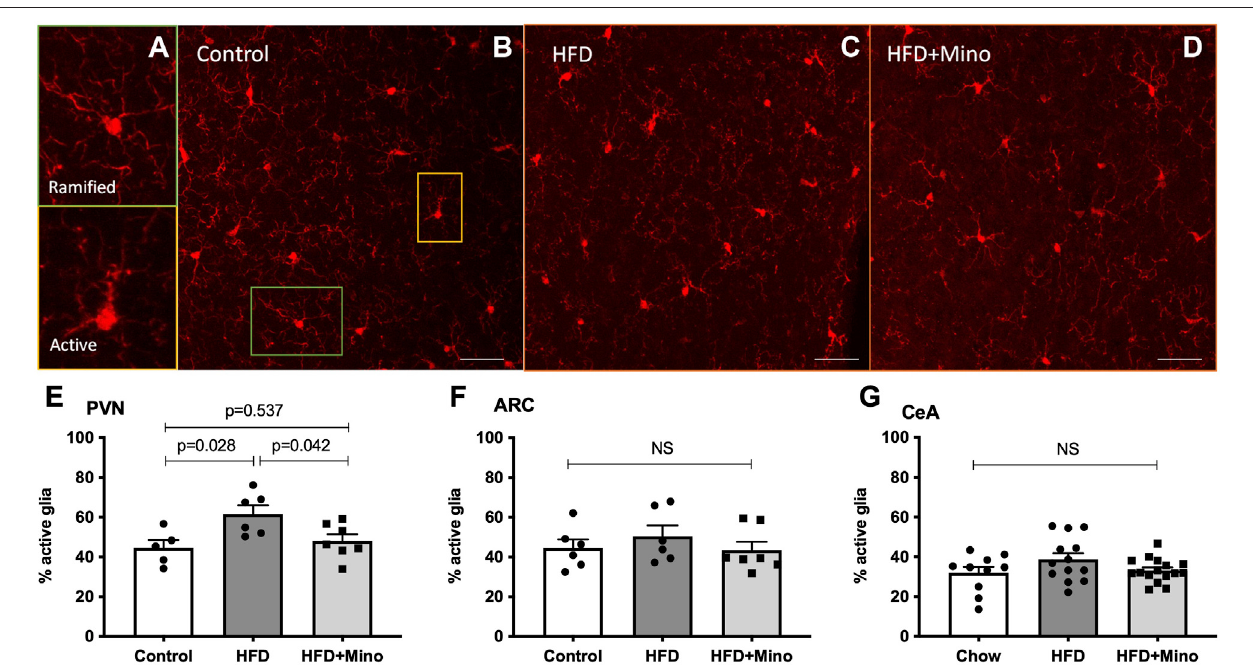
FIGURE 6 | Minocycline mitigates HFD-induced increases in active microglia in the PVN. Rami fi ed (resting) and non-rami fi ed (active) microglia were quanti fi ed following immunohistochemical staining of Iba-1 in control diet (Control; n = 7), high fat diet (HFD; n = 4), and HFD mice treated with minocycline (HFD+Mino; n = 9). (A) Exemplar images of resting microglia with small, round cell body and many long, thin process (rami fi ed) and active microglia with large, elongated cell body and few processes (non-rami fi ed). (B – D) Exemplar 40x Iba-1 images from Control, HFD, and HFD+Mino groups. Scale bar = 20 μ m (E) An increased percentage of active microglia was observed in the paraventricular nucleus (PVN) of HFD mice, which was prevented with minocycline (F – G) There was no signi fi cant effect of HFD or minocyclineonmicrogliaactivationinthearcuatenucleus(ARC)orthecentralnucleusoftheamygdala(CeA).Datawereanalyzedbyone-wayANOVAwithTukey ’ spost- hoc analysis; p <